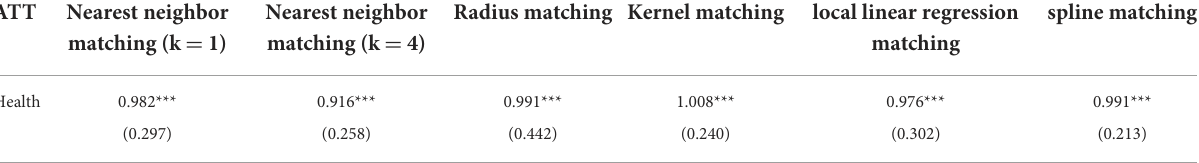
TABLE 5 The impact of mobile payment on health (accounting for self-selection).